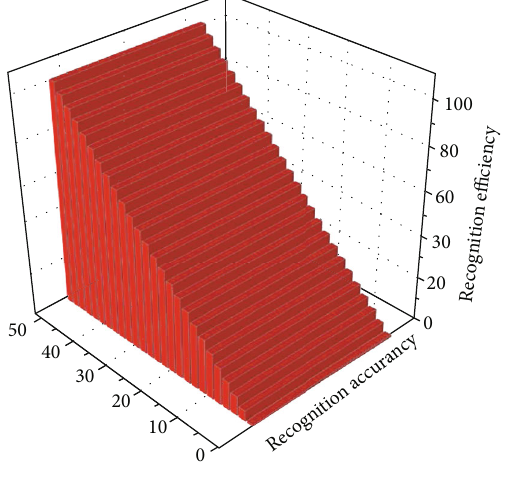
Figure 7: Comparison chart for di ff erent e ffi